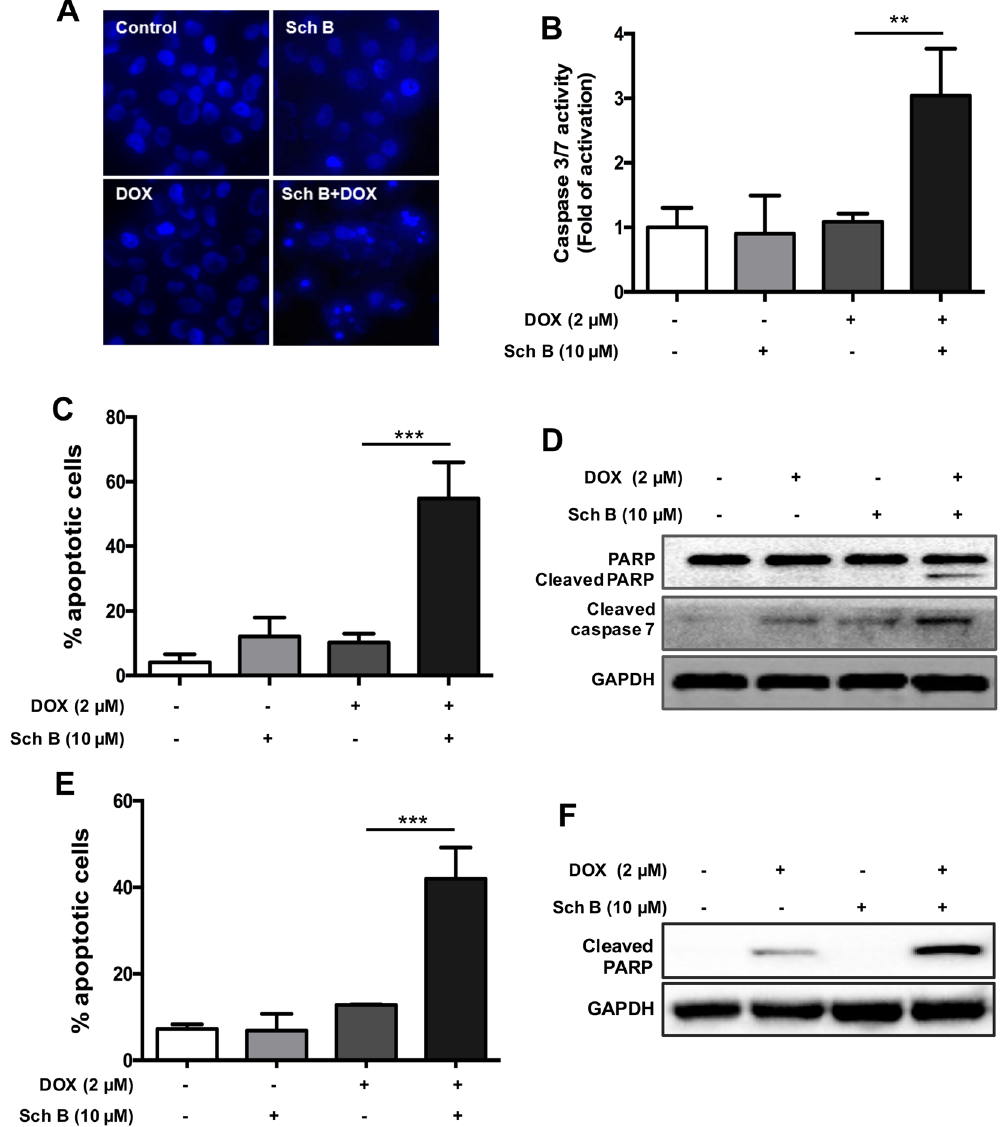
Figure 2. Sch B enhances DOX-induced apoptosis in DOX-resistant cancer cells. ( A ) MCF-7/ADR cells were treated with DOX for 48 h with or without the pretreatment of Sch B (10 μ M) for 12 h. Cells were fixed and stained with Hoechst 33342 (1 μ g/mL) and nucleus morphology analysis was performed using Incell Analyzer 2000 (GE Healthcare). ( B ) Caspase-3/7 activity of MCF-7/ADR cells was tested as described above. MCF-7/ADR ( C ) and A2780/DOX ( E ) cells were treated as described above and stained with Annexin V/PI and then cell apoptosis was analyzed by flow cytometry. ** P < 0.01 and *** P < 0.001. Western blotting of lysates from MCF-7/ADR ( D ) and A2780/DOX ( F ) cells that had been treated as described above using the indicated antibodies. Similar results were obtained in three separate